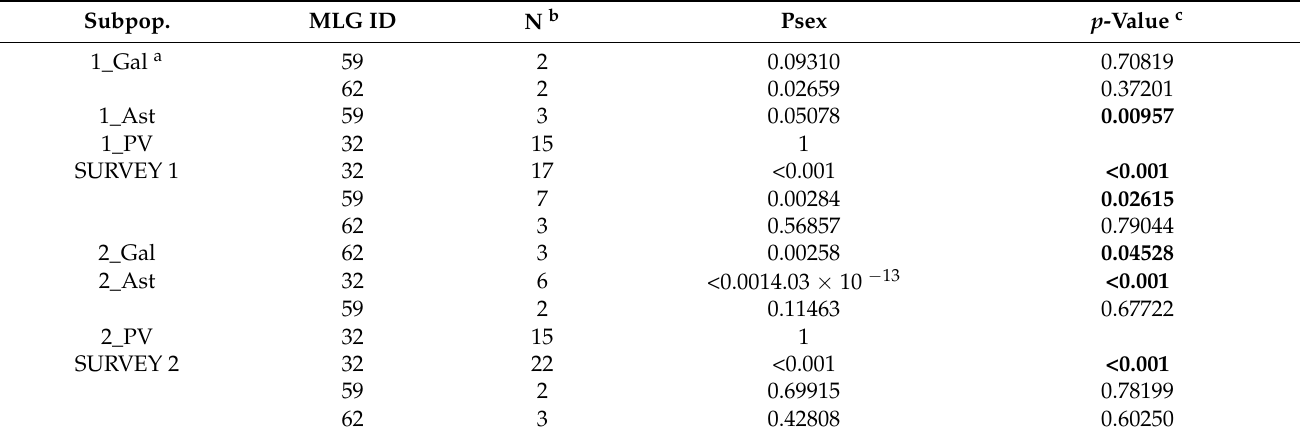
Table 4. Probability that a given MLG is found in a randomly mating population when observed more than once in the clone-corrected dataset of Spanish Fusarium circinatum population defined in a temporal scale and by geographic origin.